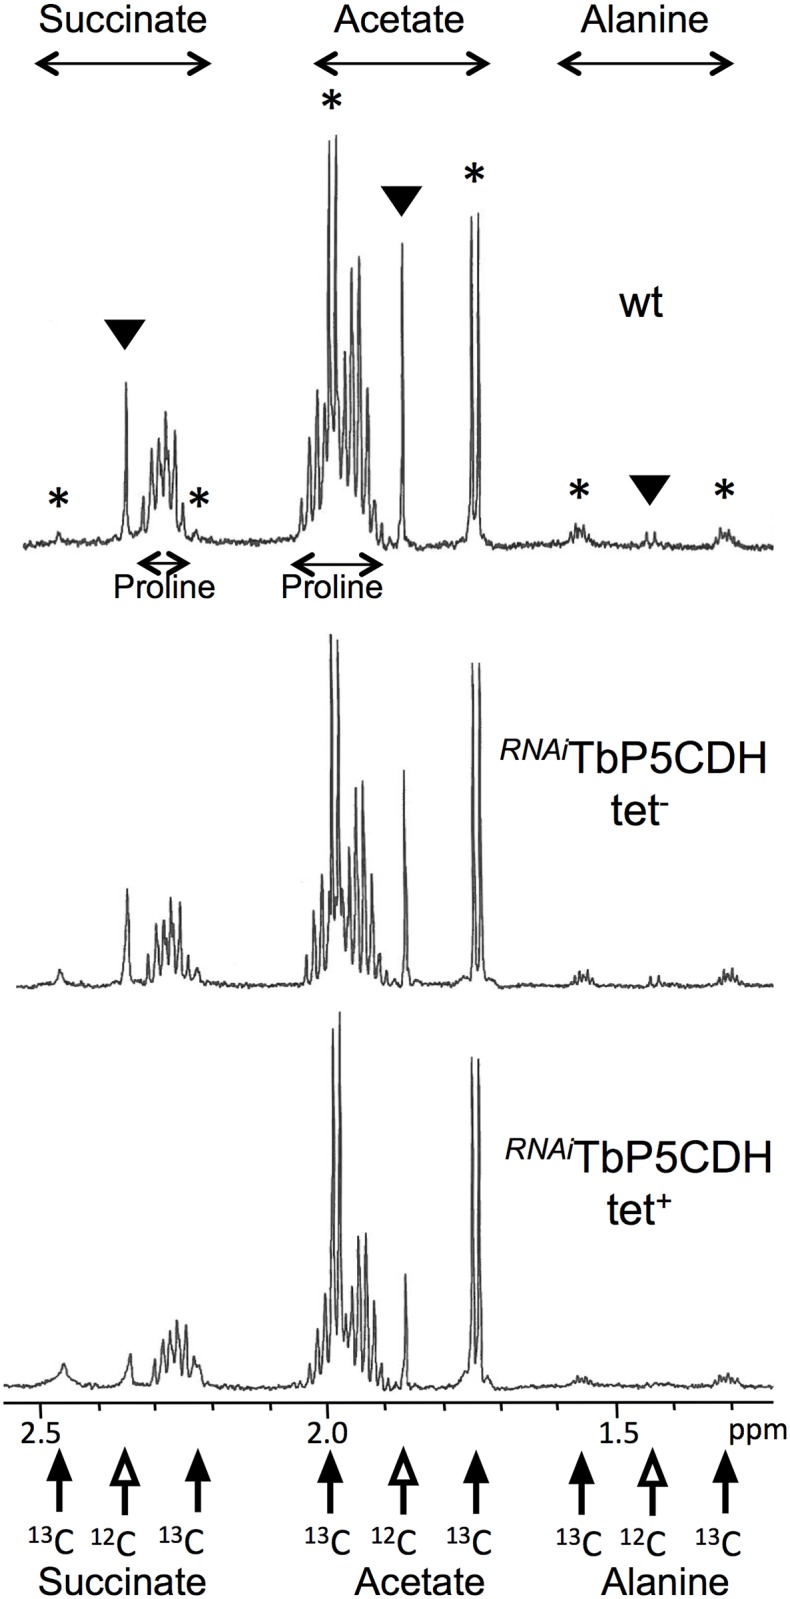
Proton NMR spectroscopy analysis of excreted end products from proline and [U-13-C]-glucose metabolism.Metabolic end products (succinate, acetate and alanine) excreted from 4 mM proline and 4 mM [U-13C]-glucose by the procyclic wt cell line, as well as the non-induced (tet-) and tetracycline-induced (tet+) RNAiTbP5CDH mutant, were determined by proton NMR spectrometry. Each spectrum corresponds to one representative experiment from a set of five biological replicates. A part of each spectrum ranging from 1.2 ppm to 2.6 ppm is shown. Resonances corresponding to 13C-enriched (13C) and non-enriched (12C) succinate, acetate and alanine molecules are indicated by closed and open arrows below the spectra, respectively, and contribution of proline and [U-13C]-glucose to succinate, acetate and alanine is shown in the top panel by arrow heads and asterisks, respectively.